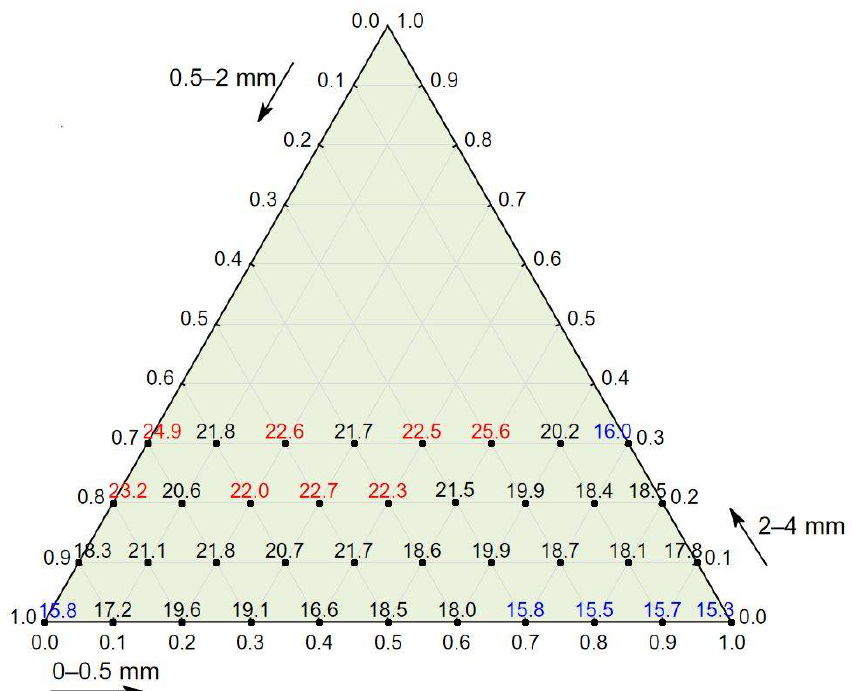
Figure 2. Compressive strength of concrete in relation to the percentage of three aggregate fraction groups. Red represents a compressive strength of 22 MPa or above, and blue represents a strength of 16 MPa or below. In order to determine the number of factors used in PCA [38], a scree plot of eigen- values was constructed. One can see that the “elbow” of the graph where the eigenvalues appear to level off is found at eigenvalue 3, which means that factors to the left of this point should be retained as they are significant. The first two factors explain 74.35% of the variance, while the first three factors explain 84.47% of the variance (see Figure 4). Two or three factors can be visualized in 2D or 3D plots.